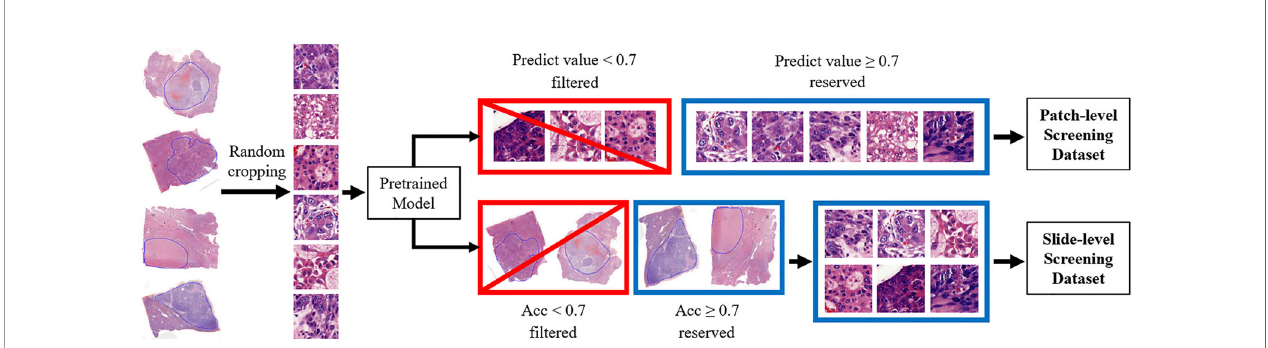
FIGURE 1 | Illustration of the process of our proposed method. Firstly, all slides of the training set were cropped randomly and used for model pretraining. Secondly, the pretrained model is trained with about 85% accuracy and then used for two different dataset screening methods. For patch-level screening, all patches were independently assessed by patch-level screening and would be fi ltered if the predicted value was below 0.7. This threshold is determined by the ablation study. For slide-level screening, patches cropped from the same slide are calculated together to fi lter the slides with low quality. Only patches of slides with 70% overall accuracy would be retained, which means that the fi nal dataset would not contain slides with unreliable